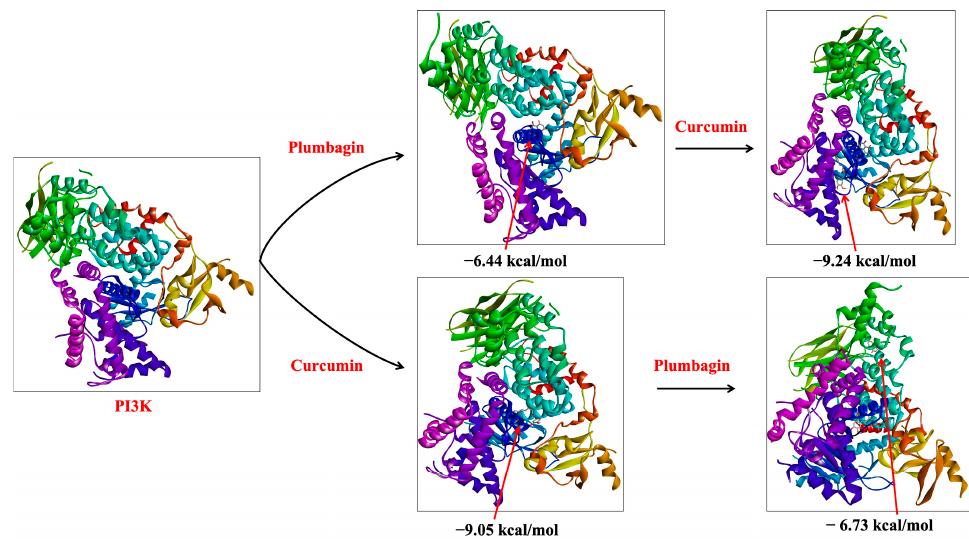
Figure 2. Sequential binding of curcumin and plumbagin after docking against PI3K protein. The red arrows indicate the position of bound ligand on the target protein.